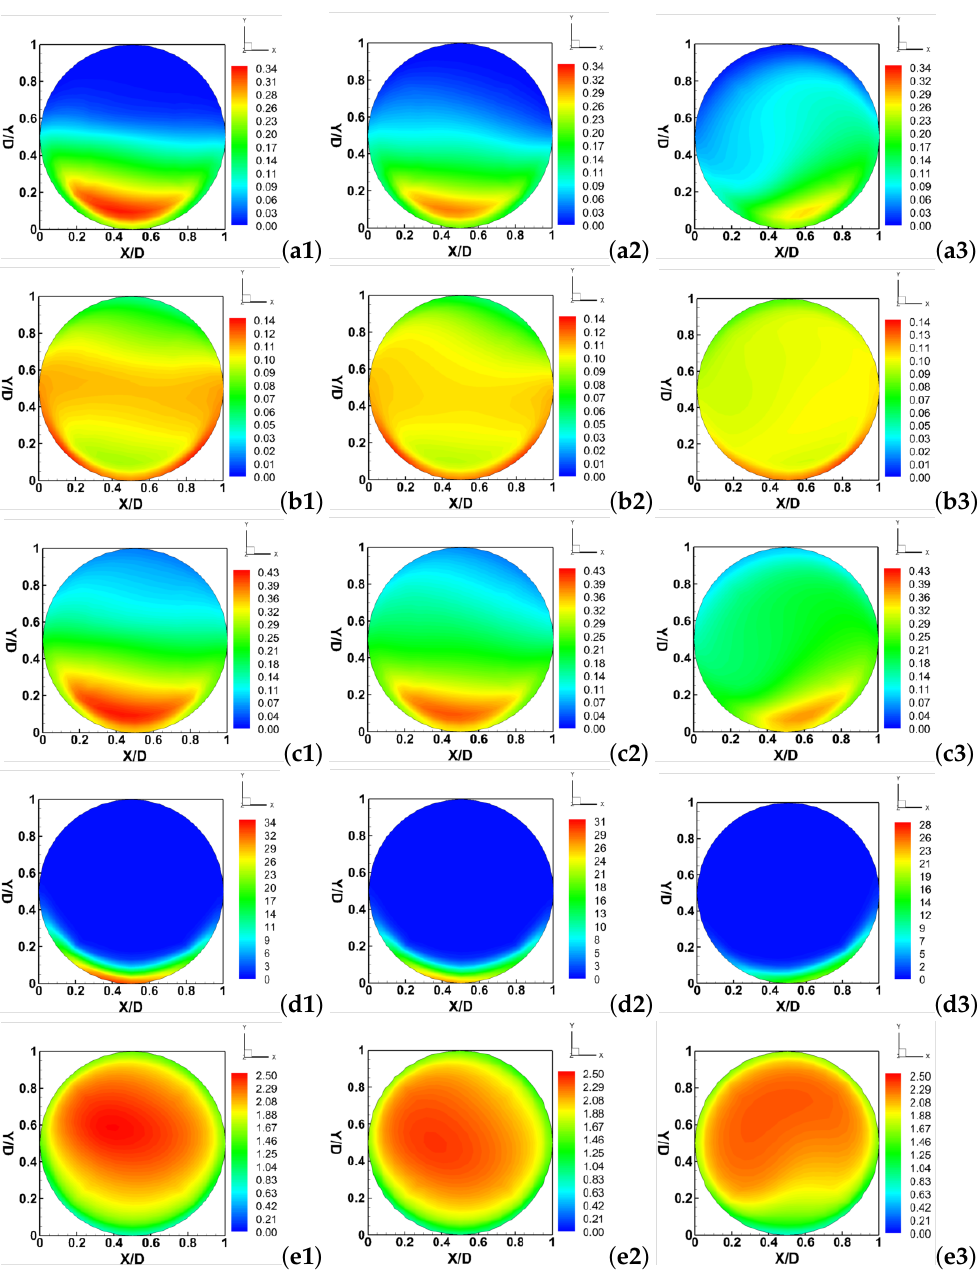
Figure 8. Contour plots for coarse particle volume fraction for SR = 0.1, 0.25 and 0.5 ( a1 – a3 ), fine particle volume fraction for SR = 0.1, 0.25 and 0.5 ( b1 – b3 ), mixture solid volume fraction for SR = 0.1, 0.25 and 0.5 ( c1–c3 ), granular pressure for SR = 0.1, 0.25 and 0.5 ( d1 – d3 ), and z-axial velocity for SR = 0.1, 0.25 and 0.5 ( e1 – e3 ) in x-y plane at z/D =